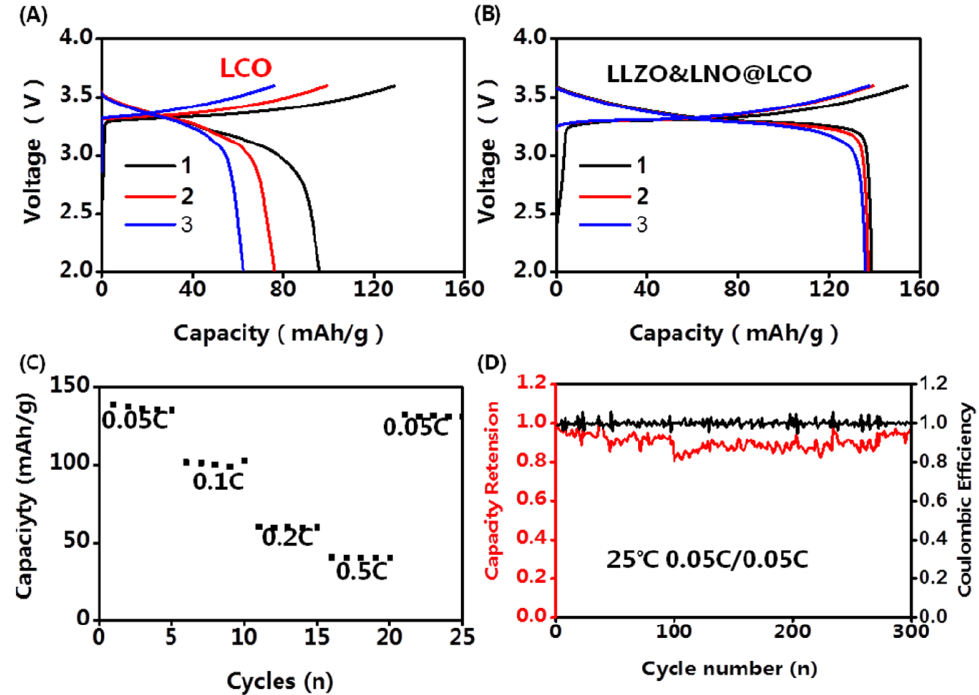
Figure 6. Charging and discharging curve of LCO||LPSC||Li-In ( A ) and LLZO&LNO@LCO||LPSC||Li-In ( B , C ) discharging capacity of LLZO&LNO@LCO at a different rate, ( D ) lifecycles of LLZO&LNO@LCO||LPSC||Li-In at 0.05 C.